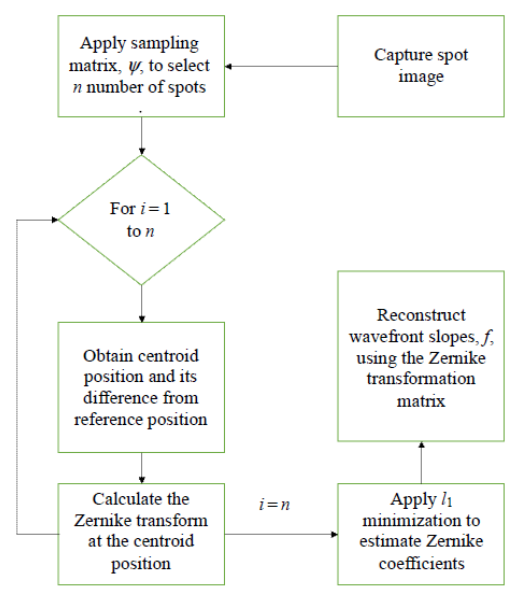
Fig. 4 Flow Chart of the wavefront reconstruction